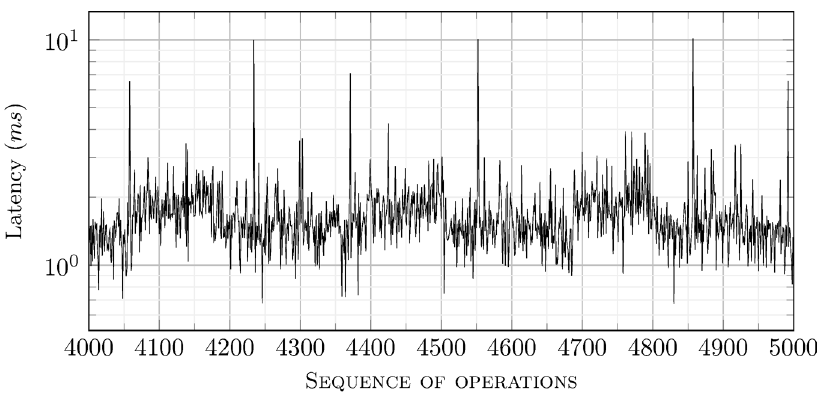
Figure 18. Latency values for the fifth series of 1000 requests/responses.